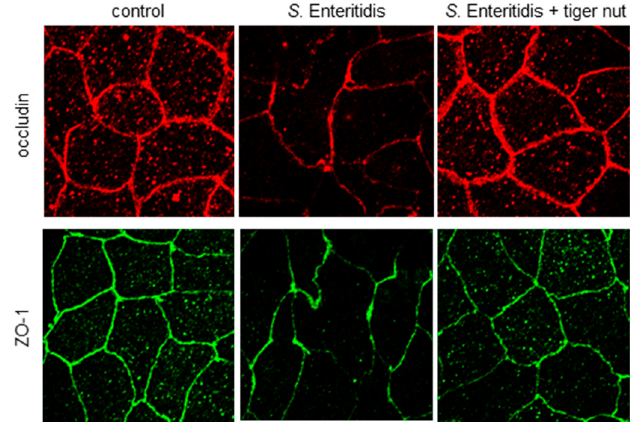
Figure 2. Effect of tiger nut on the immunolocalization of occludin and ZO-1 in Caco-2 cells incu- bated with S . enteritidis. Cultures were incubated for 3 h in the absence (control) or presence of S . enteritidis (MOI 10) and tiger nut (2.5 mg/mL). Representative results were reproduced in three separate experiments.